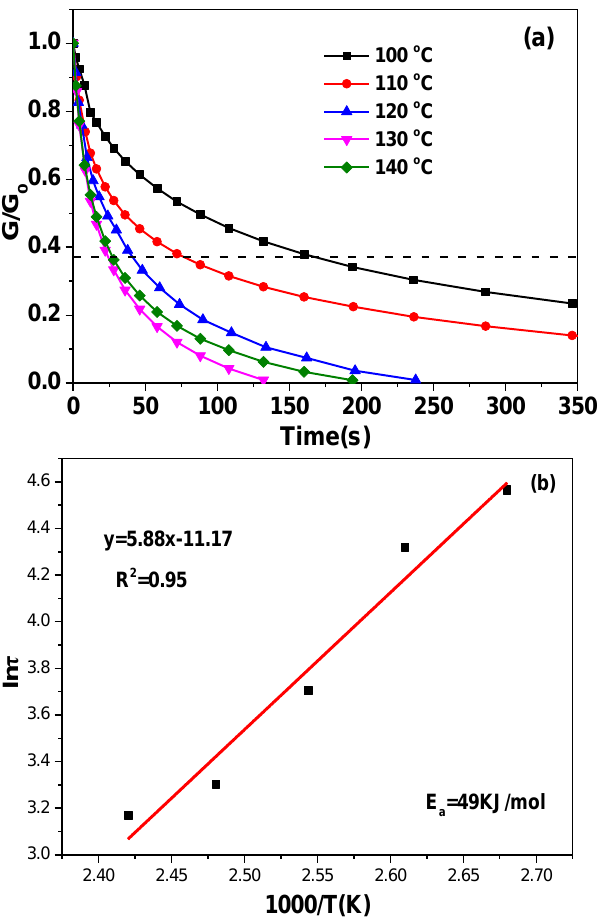
Figure 7. ( a ) Stress relaxation study of 20% C-FPAE. ( b ) Arrhenius plot with linear fit for 20% C-FPAE.